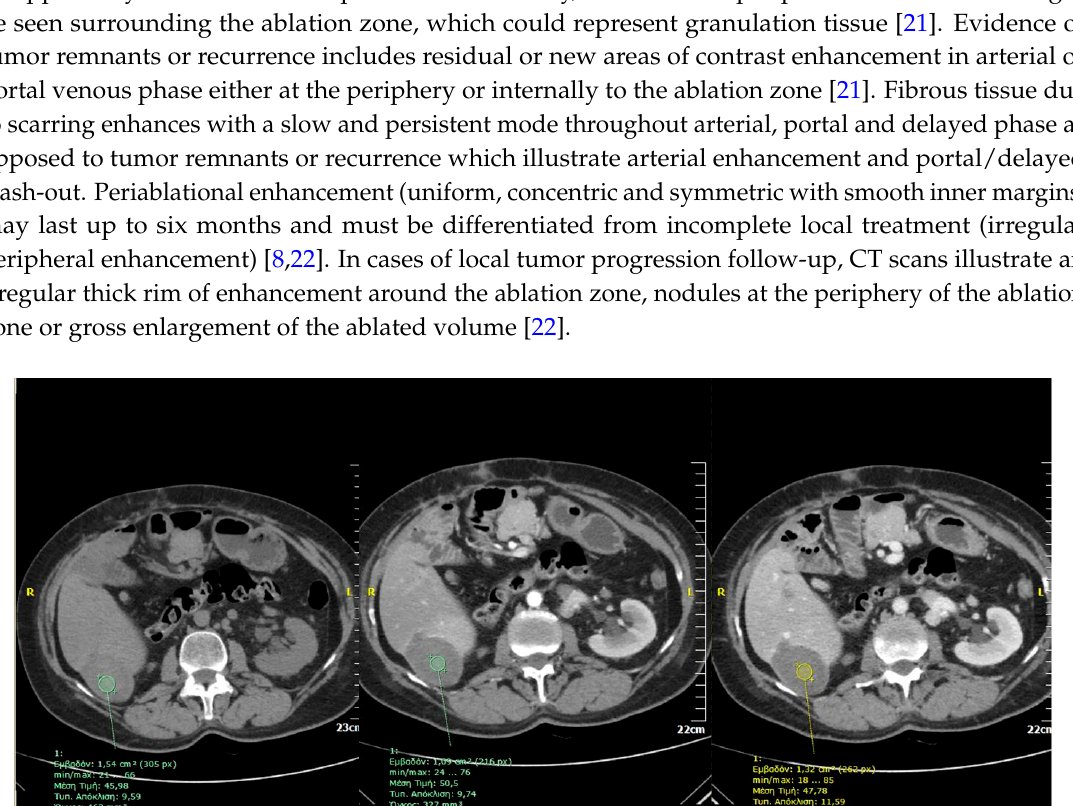
Figure 2. CEUS diagnosis of partial response post ablation. CEUS images of a hypervascular HCC at baseline (A), and one month post ablation (B). At baseline, the tumor shows intense, early enhancement. Post ablation, a nodular residual tumor, also exhibiting strong, early enhancement, is noted (arrows).